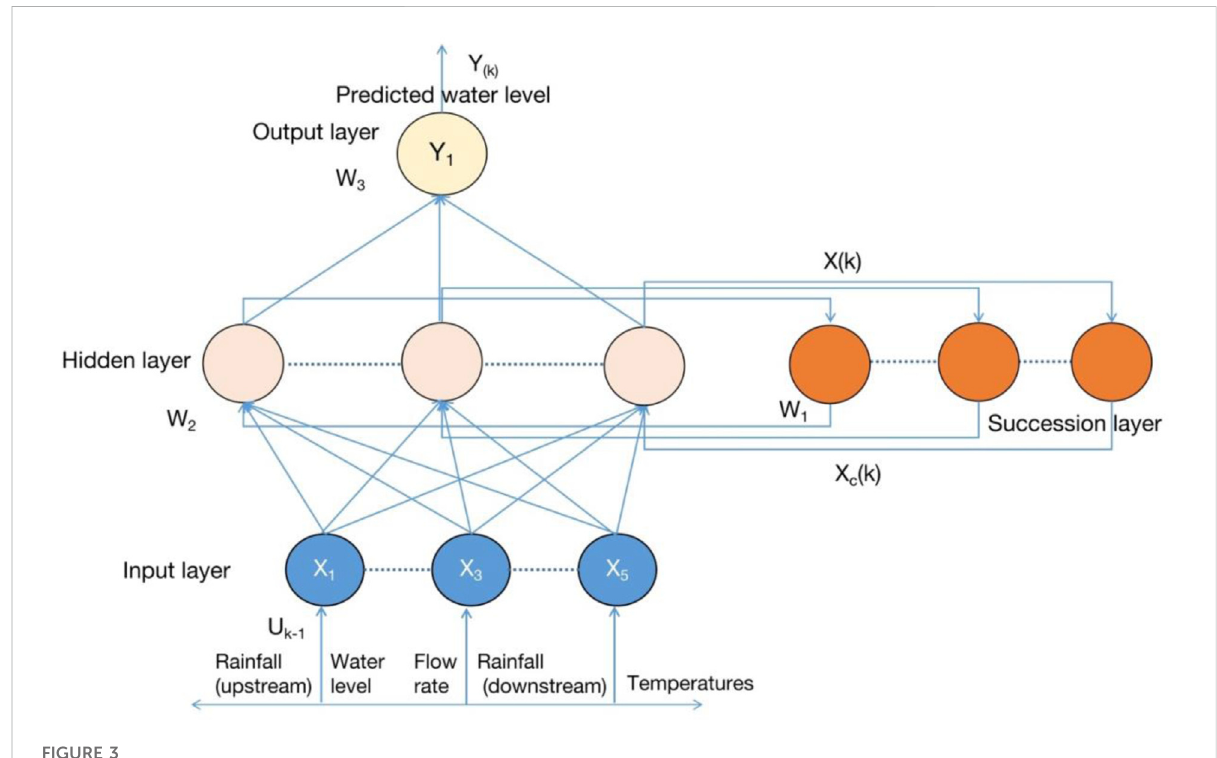
FIGURE 3 Network architecture of Elman Neural Network (ENN) for this